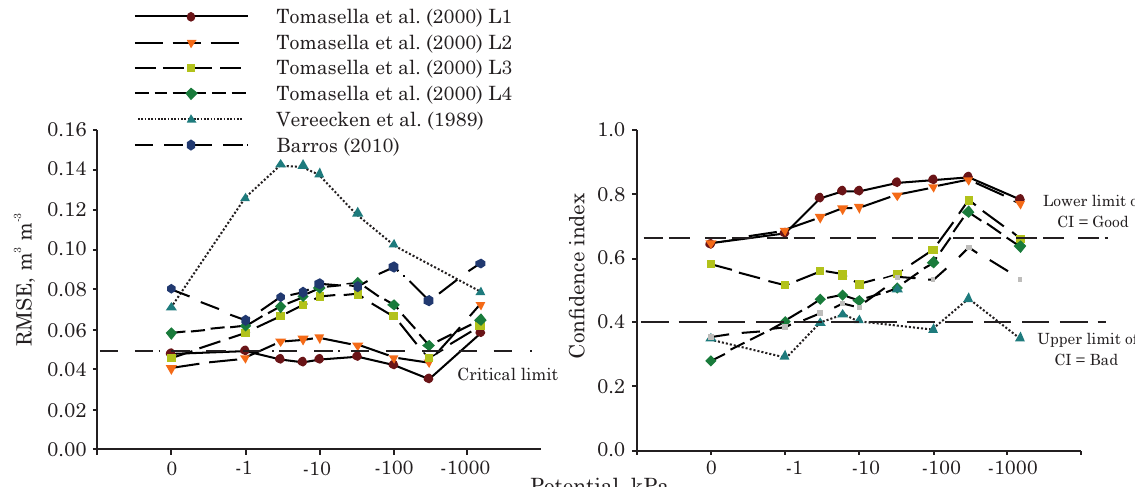
Figure 2. Values of RMSE and confidence index (CI) for the parametric PTFs tested for all soil depths; CI > 0.85 = optimum; CI from 0.85 to 0.76 = very good; CI from 0.75 to 0.66 = good; CI from 0.65 to 0.61 = average; CI from 0.60 to 0.51 = tolerable; CI from 0.50 to 0.41 = bad; CI 0.40 = very bad.